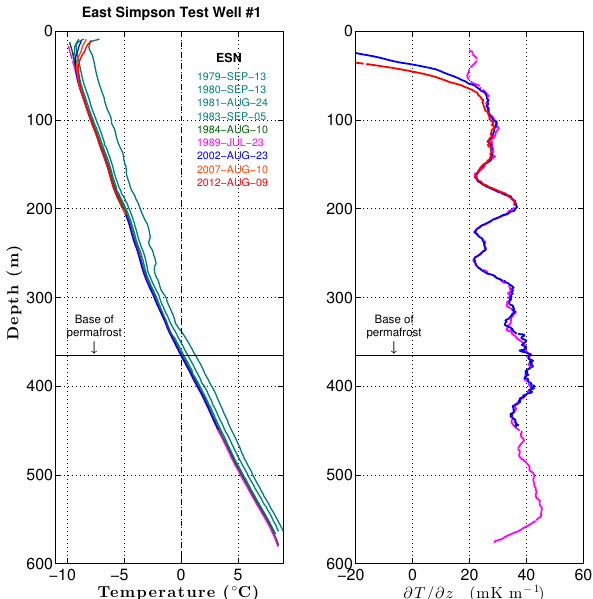
Figure 11. Temperature profiles in the East Simpson Test Well No. 1, color-coded by acquisition date (left). Temperature gradients calculated from the 1989, 2002, and 2012 logs are shown in the right